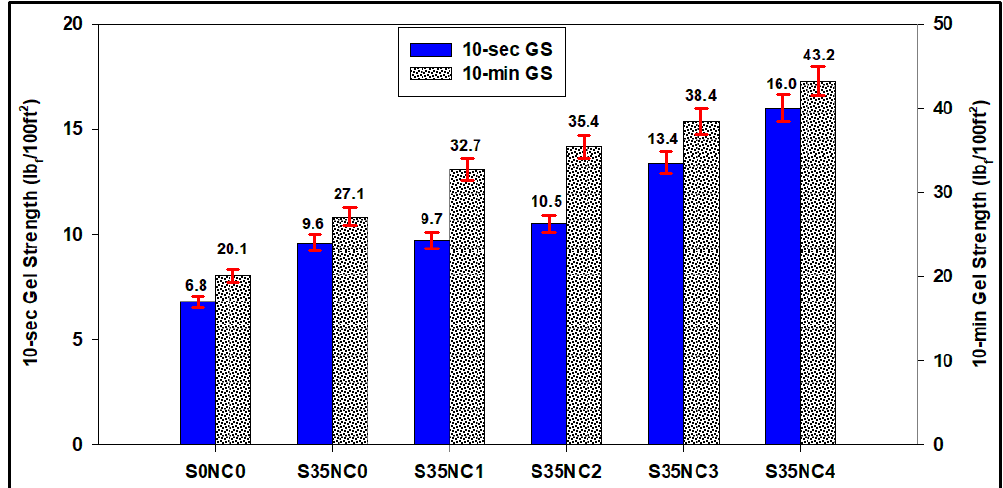
Figure 9. Comparison of the 10-s and 10-min gel strengths for all cement slurries.